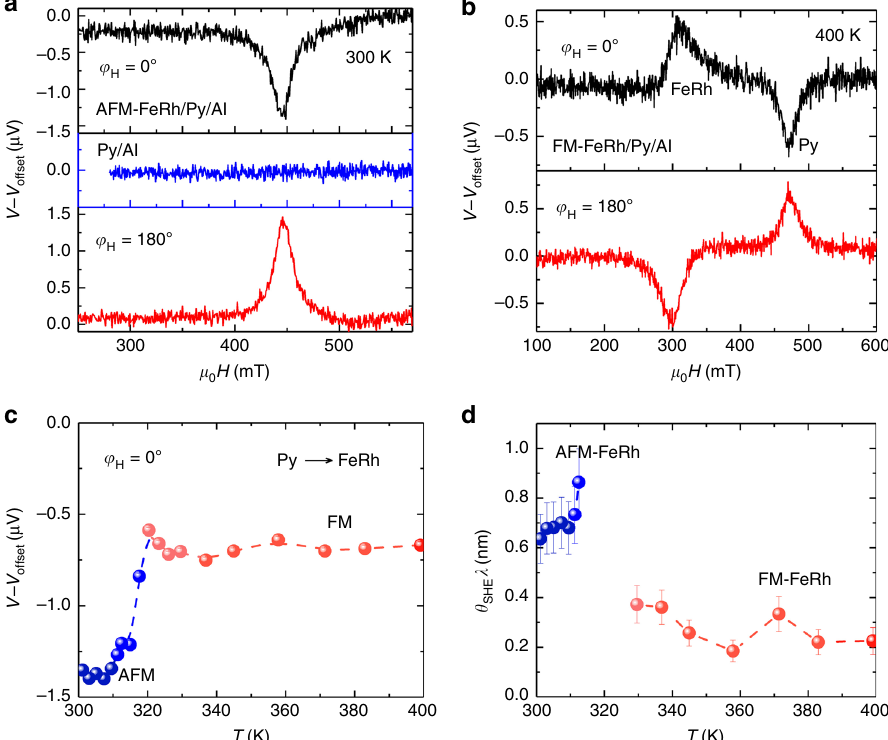
Fig. 5 Vertical spin pumping in FeRh/Py/Al. a Pure spin pumping voltages acquired at φ H = 0° and 180° at 22 GHz and 300 K, when FeRh is in AFM state. b Pure spin pumping voltages acquired at 400 K, when FeRh is in FM state. Mutual spin pumping from Py into FeRh (FMR of Py), or from FM-FeRh into Py (FMR of FeRh), is observed. c Temperature dependence of ISHE voltages measured at the FMR of Py. The error bars are smaller than the size of the symbols. d Temperature dependence of spin-to-charge conversion ef fi ciency of FeRh, which shows a larger spin-to-charge conversion ef fi ciency at the AFM phase, indicating that AFM-FeRh can be a good spin sink. The errors bars in c and d are standard deviations obtained from the fi